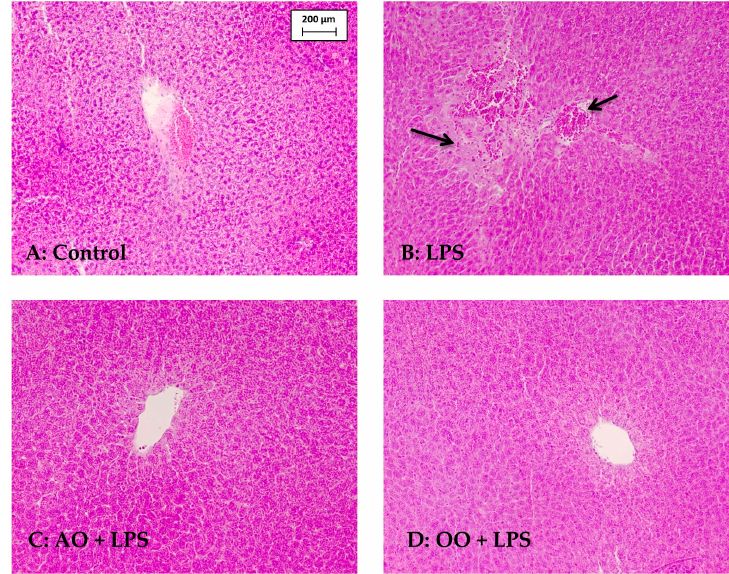
Figure 1. Preventive effect of Argan oil supplementation on LPS (lipopolysaccharide)-induced liver injury. Mice liver sections were stained with hematoxylin–eosin. Control mice ( A ) showed normal liver histologies; LPS group ( B ) showed large foamy lipid-laden macrophages and inflammatory cells (arrows); AO (argan oil) + LPS group ( C ) revealed an interlobular portal vein surrounded by radiating normal hepatocyte plates; ( D ) OO (olive oil) + LPS group showed a normal liver parenchyma surrounding a portal vein (magnification×200).